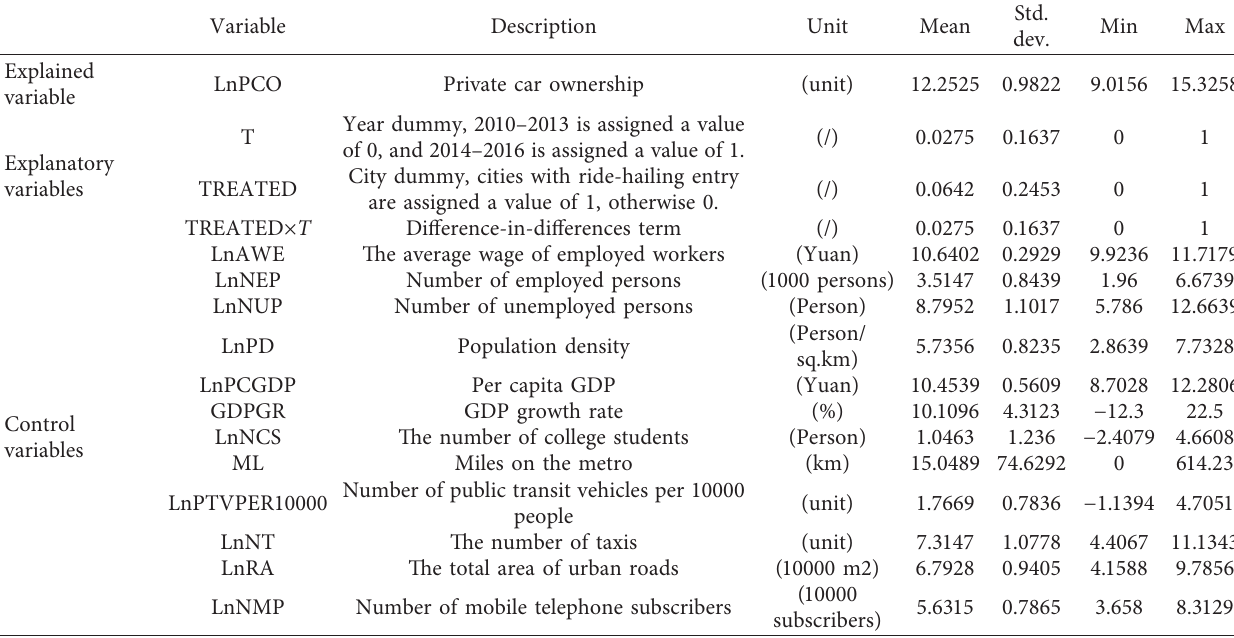
Table 3: Definition and descriptive statistics of the main variables.